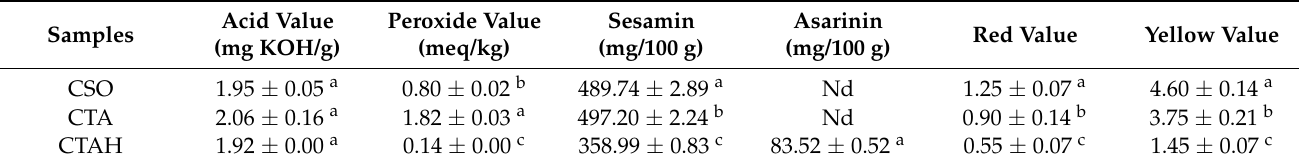
Figure 6. Response surface plots and corresponding contour plots of the effects of different factors on asarinin yield. Interaction of temperature and catalyst amount ( a , b ); interaction of time and catalyst amount ( c , d ); interaction of time and temperature ( e , f ). Table 5. Acid value, peroxide value and lignans of different treated sesame oil